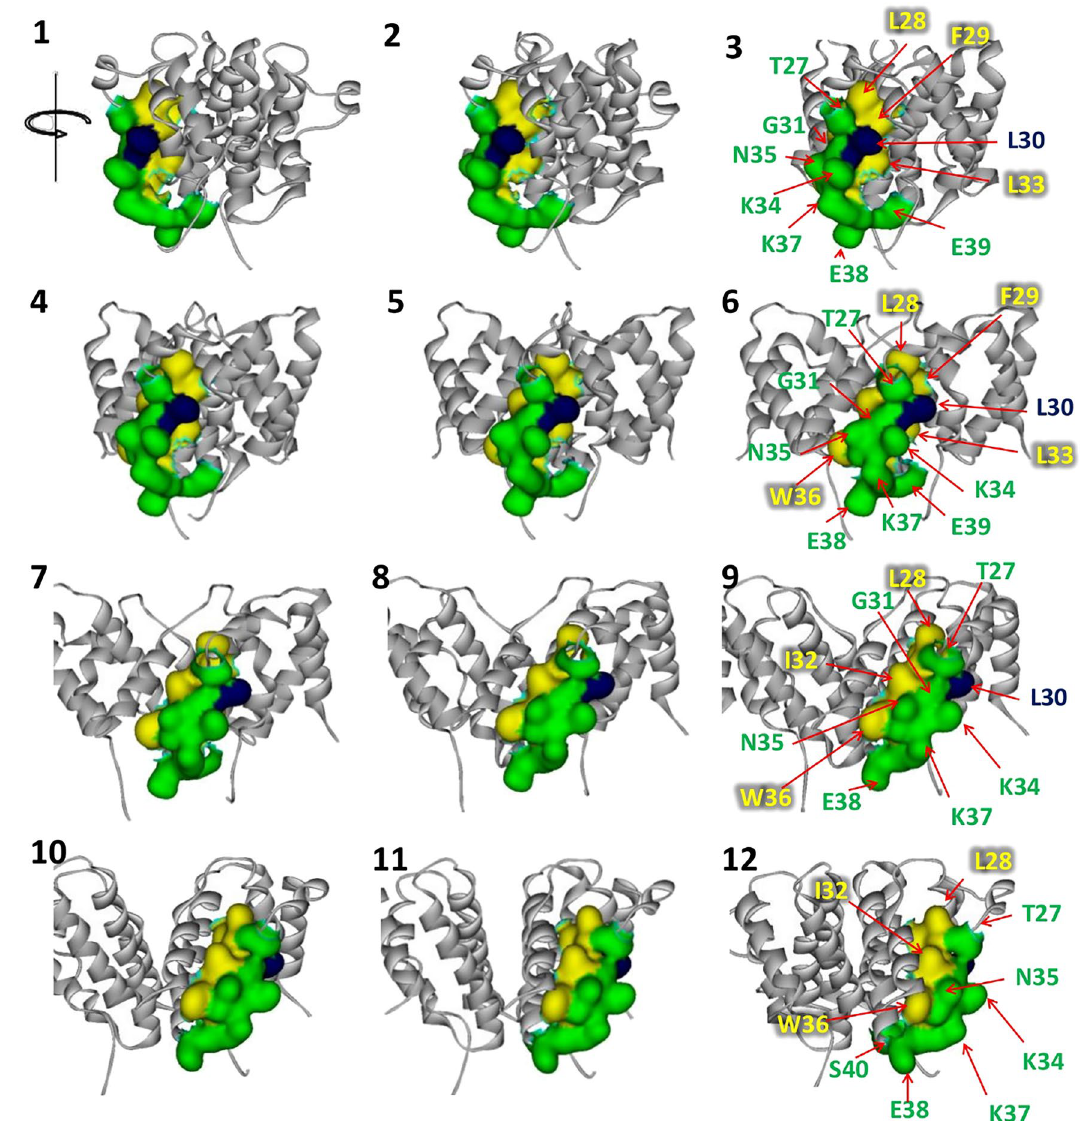
Figure 2. Rotation view of solvent accessible residues of 27 TLFLGILKNWKEES 40 in human IFN-γ. The buried (yellow), exposed (green), and intermediate (blue) residues were classified with respect to % SASA, < 10%, > 25%, and 10%–25%,